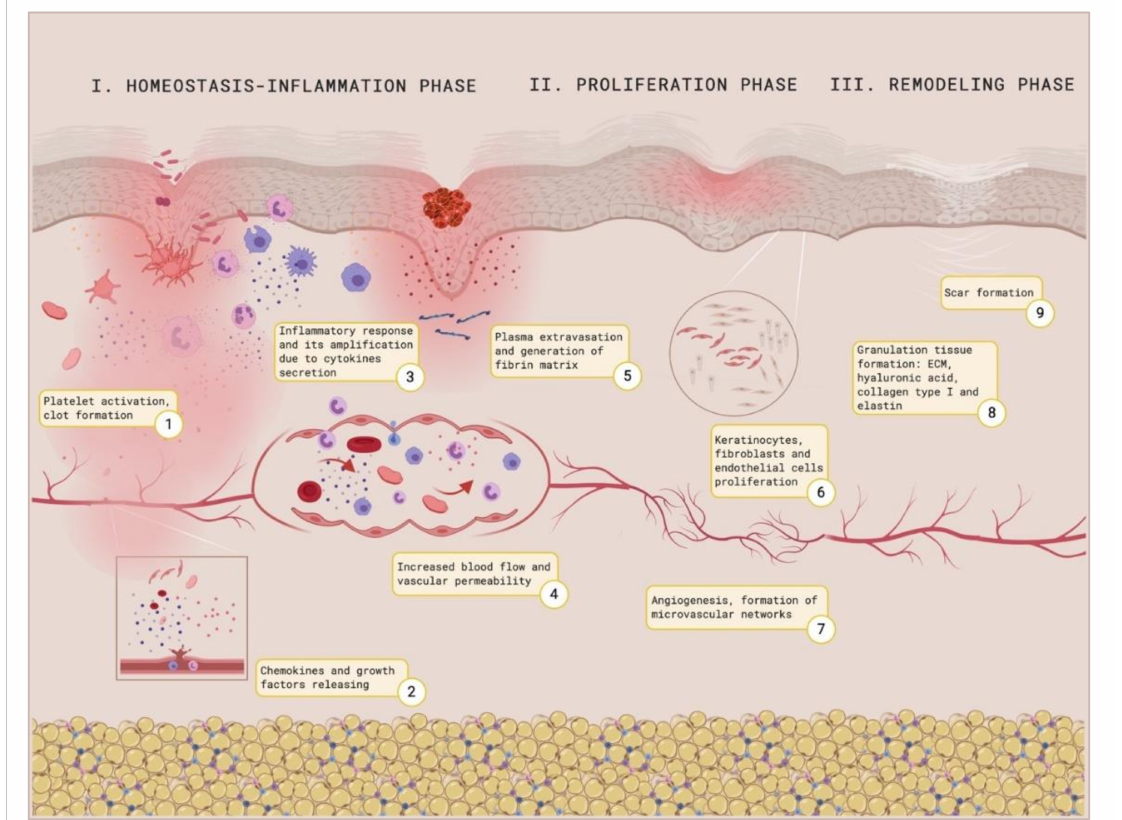
Figure 5. Wound healing illustration. Created with